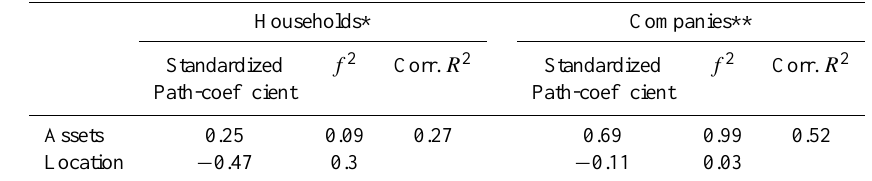
Table 4. Prediction model for asset